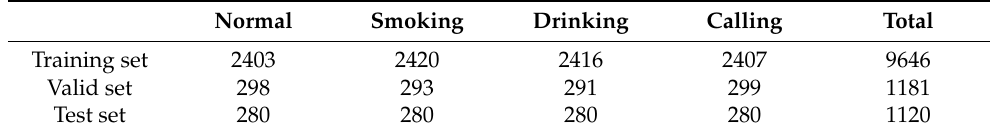
Table 1. Data volume of risky-driving-image dataset.